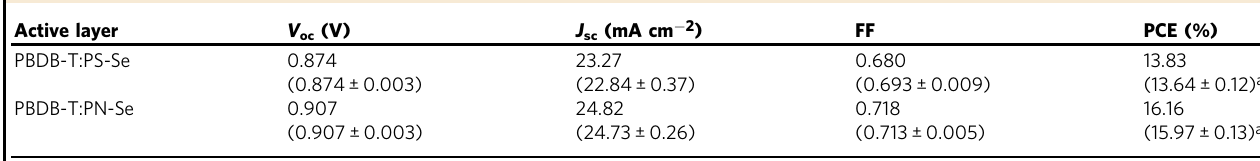
Table 1 Photovoltaic parameters of the optimal all-PSCs based on PBDB-T:PSMAs (1.5:1, w/w), measured under the illumination of AM1.5 G, 100 mW cm − 2